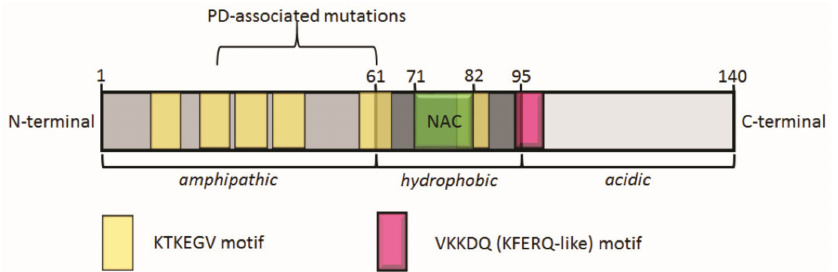
Figure 1. Schematic representation of full-length α -synuclein structure (140 amino acids). α -synuclein consists of an amphipathic region from amino acid 1 to 61 with several repetitions of the conserved KTKEGV motif. This region is involved in membrane binding. The hydrophobic part of α -synuclein extends from amino acid 62 to 95 and comprises the non-amyloid β -component (NAC) region, which is important for promoting aggregation. From amino acids 96 to 140, α -synuclein features an acidic region, which is involved in ligand binding. Moreover, α -synuclein holds a VKKDQ (KFERQ-like) motif that is the binding site for heat shock cognate 70 (Hsc70) inducing degradation via chaperone-mediated autophagy (CMA)